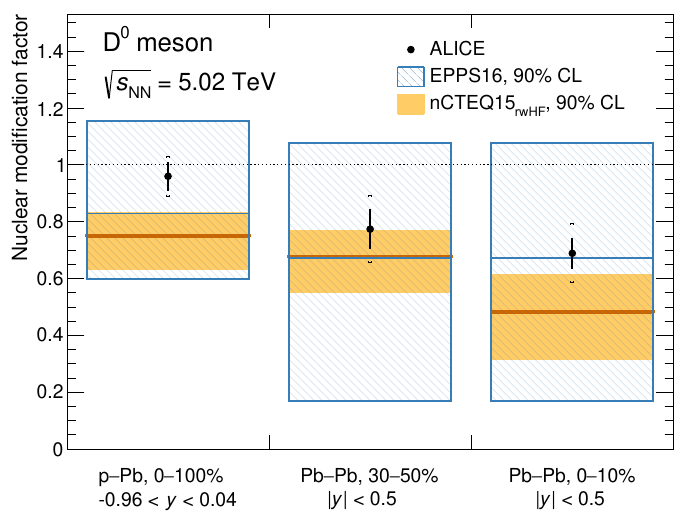
Figure 8 . p T -integrated nuclear modification factors of prompt D 0 mesons measured in p–Pb [33] √ and Pb–Pb collisions at s = 5 . 02 TeV . Statistical (bars) and systematic (brackets) uncertainties NN are shown. The results are compared with calculations at 90% of confidence level of theoretical models nCTEQ15 (with Bayesian reweighting, see text for details) [77–81] and EPPS16 [82, 83] that include only initial-state